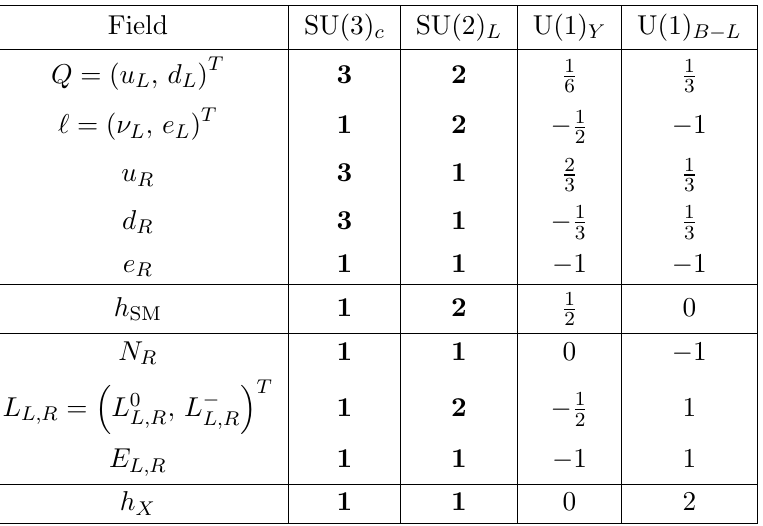
Table 1 . Field content of the model and transformation properties under the gauge group SU(3)